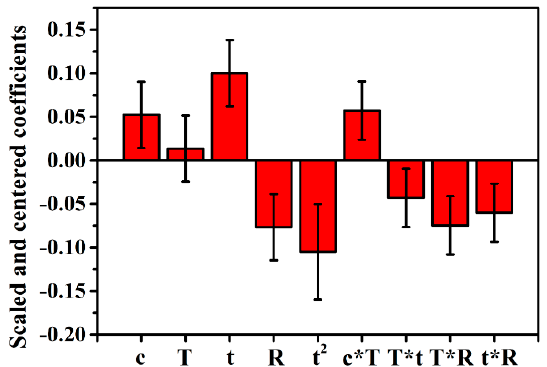
Figure 3. The scaled and centered coefficients plot of the diameters.